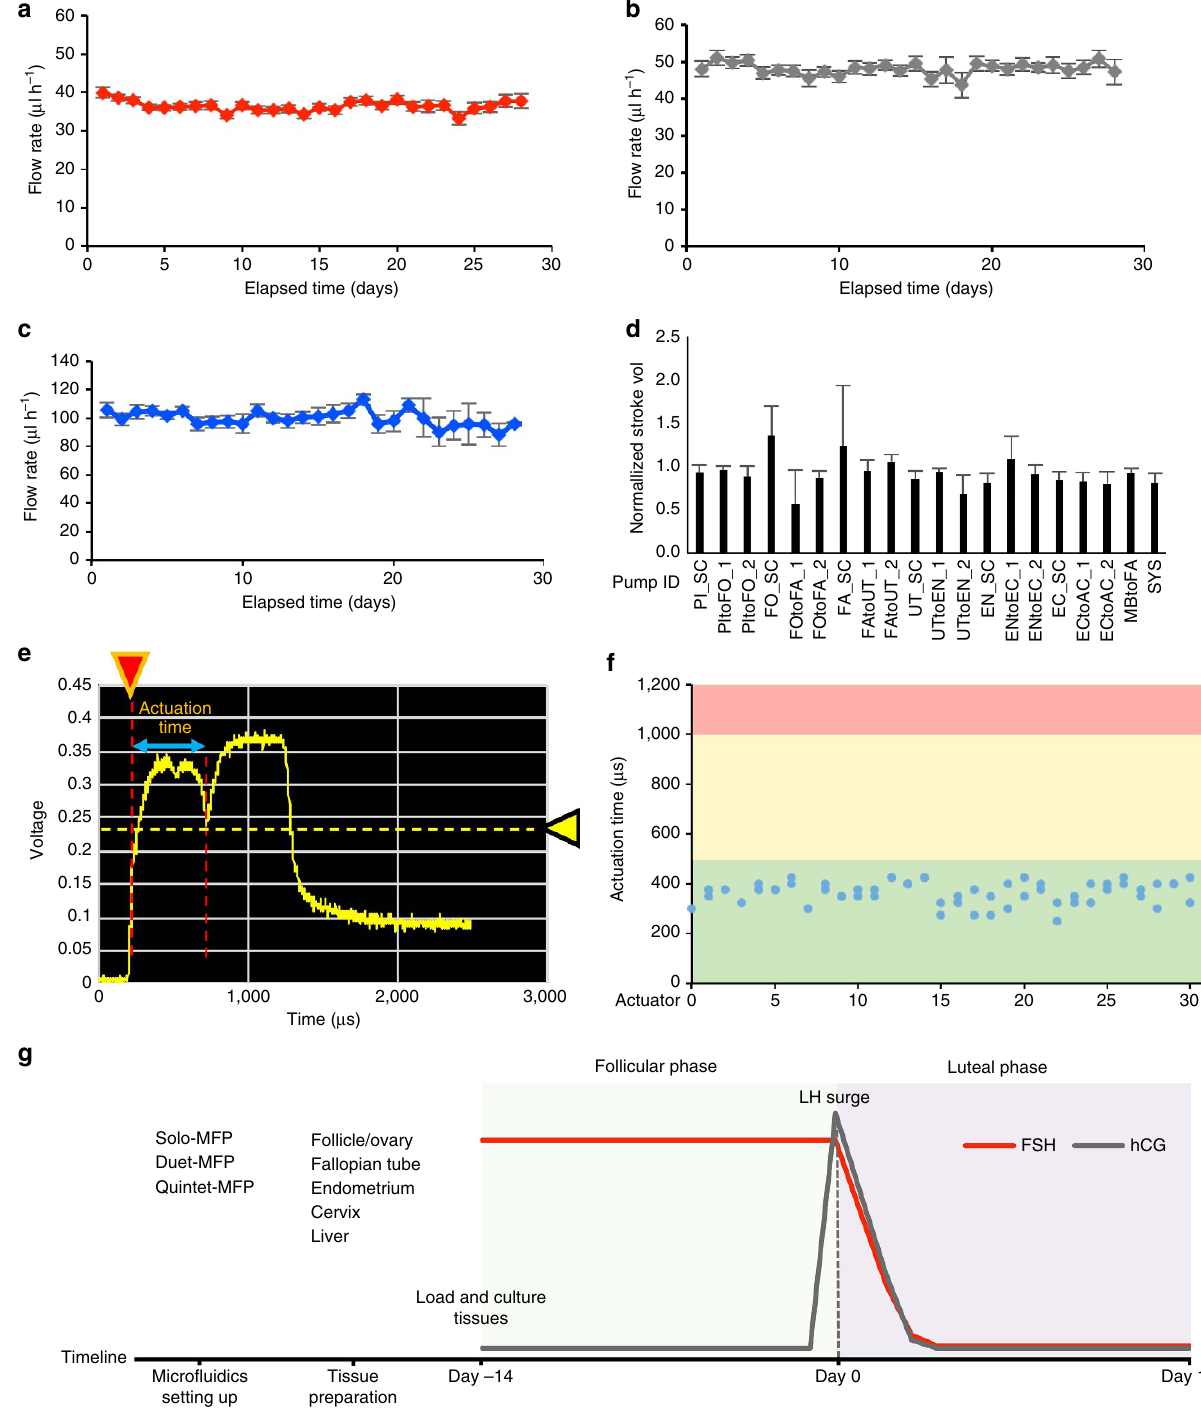
Figure 2 | The pumping scheme of microfluidic platforms and experimental procedures. The average flow rates of ( a ) Solo-MFP ( n ¼ 19), ( b ) Duet-MFP ( n ¼ 23) and ( c ) Quintet-MFP ( n ¼ 10) systems. ( d ) Average stroke volume for each pump pathway in the Quintet-MFP over the course of 33 days normalized with respect to the initial value. ( e ) Example oscilloscope reading illustrating how the actuation time was measured to determine the status of actuator function. Red arrow: trigger position; yellow arrow: trigger level. ( f ) A plot of Quintet-MFP actuator status at the beginning of an experiment with the upper and lower bounds of 625 and 250 m s, respectively. ( g ) Timeline for microfluidic platform setup, tissue preparation and culture. Graphs in a – d display average þ s.d. n ¼ 4 replicates for the microfluidic platform testing.